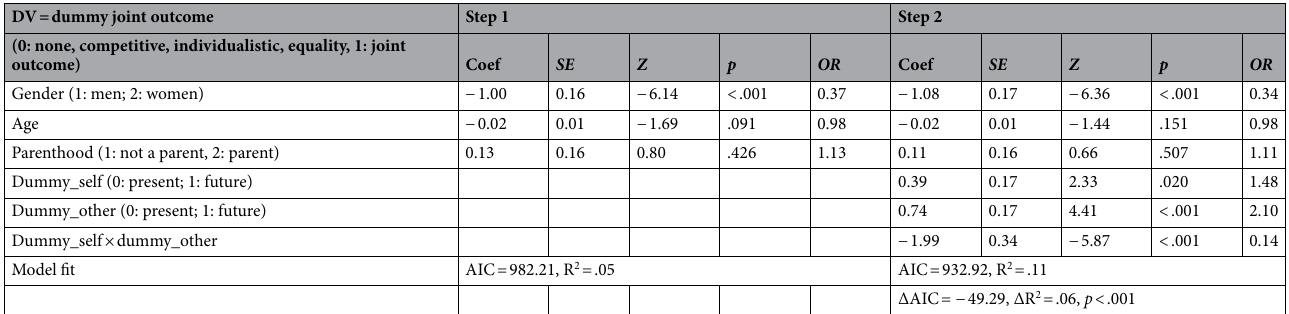
Table 4. Results of logistic regressions for the joint outcome dummy variable. R 2 indicates Cox and Snell R 2 values. Coef. = coefficient; SE = standard error; OR = odds ratio; AIC = Akaike’s information criteria.